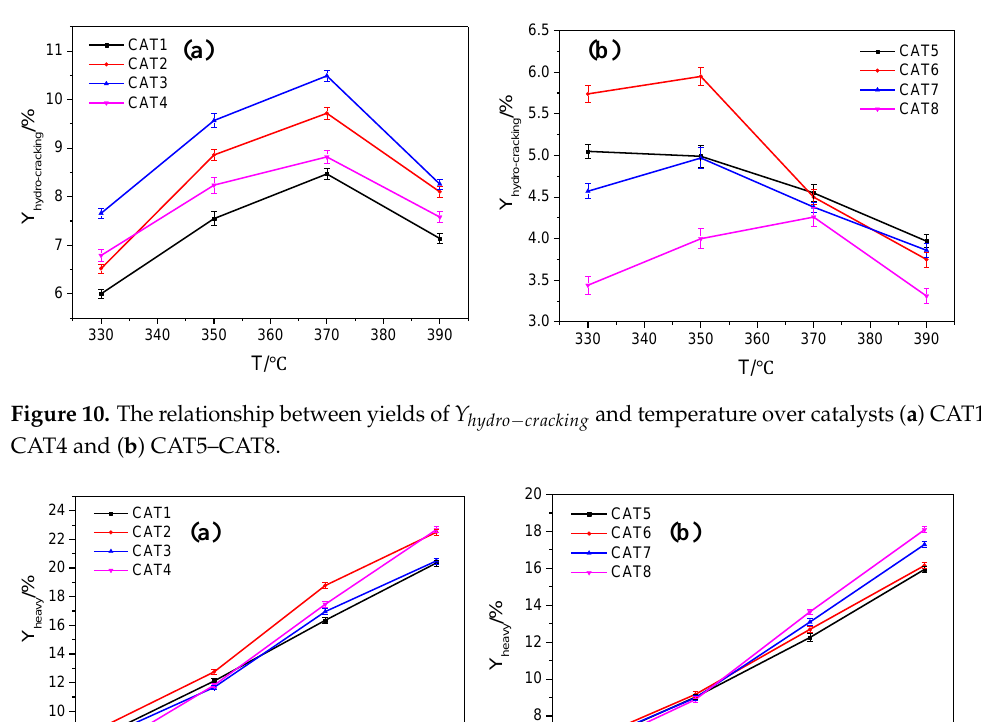
CAT1 – CAT4 and ( b ) CAT5 – CAT8.